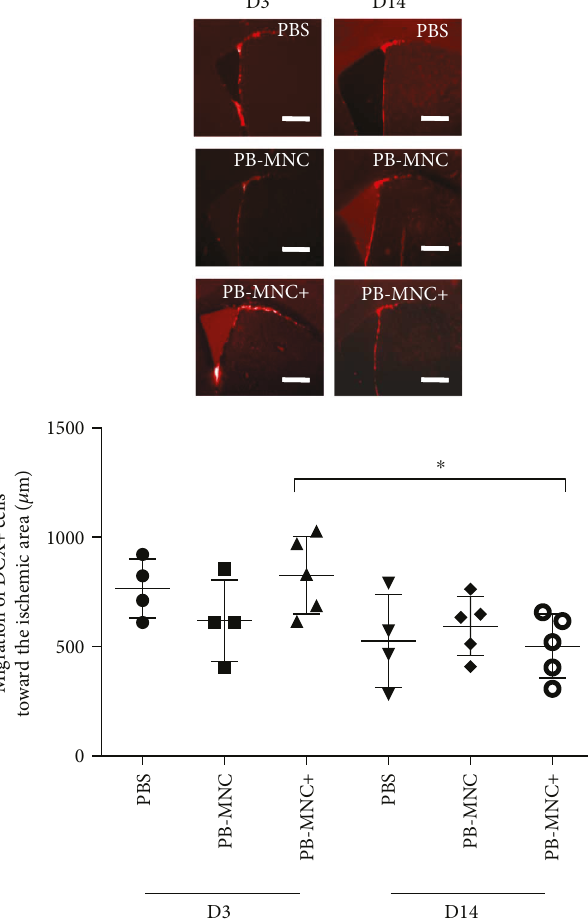
Figure 7: Neuroblast migration is not enhanced in mice treated with diabetic PB-MNC+. At D3 and at D14, there were no signi fi cant di ff erences between the three groups in terms of the migration of DCX+ cells toward the ischemic area ( N = 4 – 5 /group). Between D3 and D14, there was a signi fi cant reduction in terms of neuroblast migration in PB-MNC +-treated mice. Data are presented as mean ± SD. ∗ P < 0 05 . Scale bar =200 μ